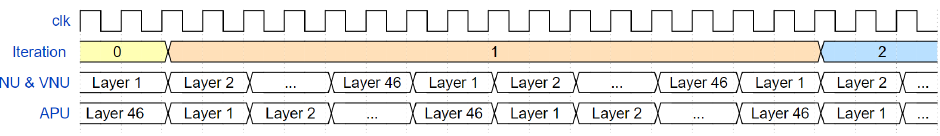
Figure 11. Pipeline schedule of the proposed QC-LDPC